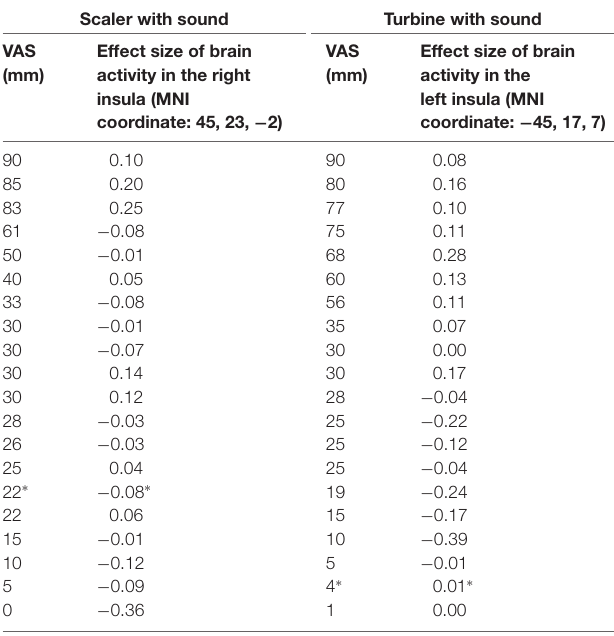
TABLE 4 | Brain activity level in response to scaler or turbine video with respective dental fear visual analog scale (VAS) score ( n = 20). Scaler with sound Turbine with